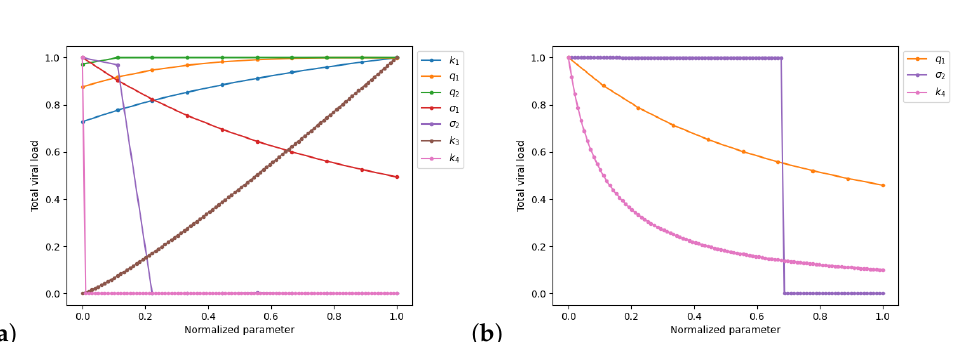
Figure 3. The dependence of the total viral load in the system (1)–(5) on parameters. ( a ) All the parameters are in their estimated ranges from Table 1, and the ranges are projected to the [ 0,1 ] interval by a linear function. For each varying parameter, the other ones are fixed using the following values: k 1 = 0.055, q 1 = 0.1, σ 1 = 3, σ 2 = 0.08, k 3 = 100, q 2 = 8, k 4 = 0.1, D = 0.01, A 0 = 1, L = 10 cm. Units of the parameters are the same as in Figure 2. ( b ) The parameter k 4 is in the range [1.9 × 10 − 5 , 1.9 × 10 − 4 ], and parameter σ 2 is in range [ 0.129,0.131 ] . These are the ranges corresponding to the straight lines for these parameters on the left figure. The dependence for the parameter q 1 is represented for the other set of fixed parameters (values from Table 1).